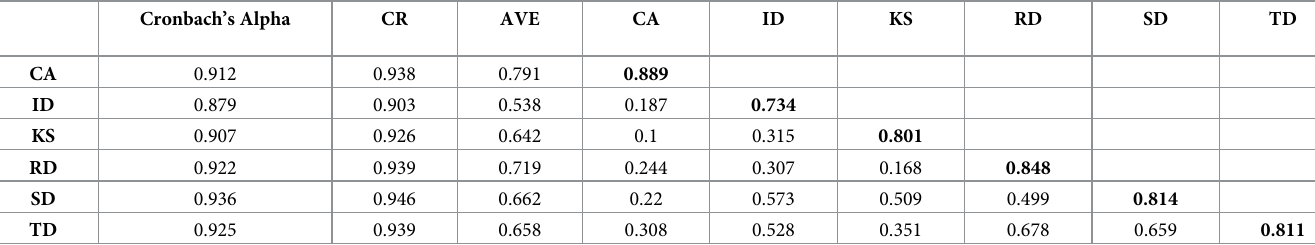
Table 3. Construct reliability and validity.